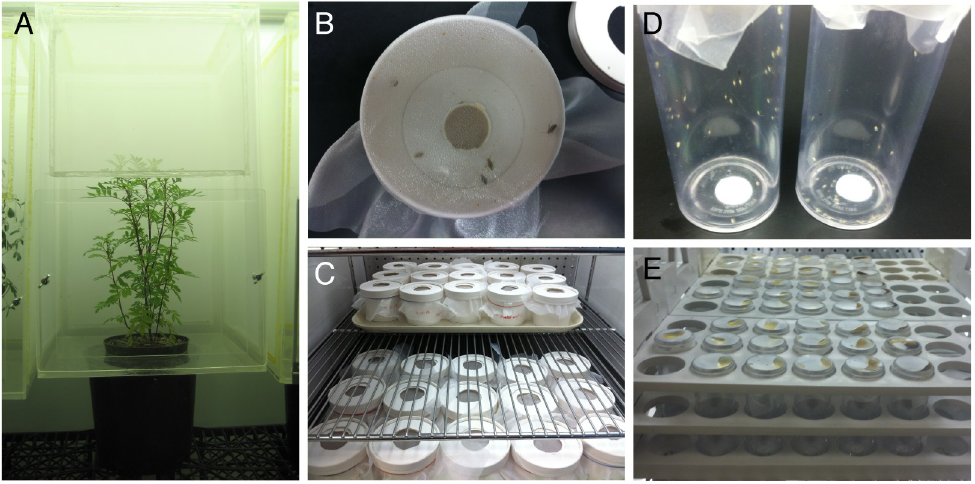
Fig 1. On-plant and diet-incorporation assays for adult Lygus hesperus and Bemisia tabaci . For on-plant assays (A), live adults were released into plexiglass cages with either marigold or control (common bean) plant and survival was assessed daily for 13 d. For incorporation assays, marigold extracts were mixed into diets for L . hesperus (B and C) or B . tabaci (D and E) and survival was recorded daily for up to 3 ( B . tabaci ) or 14 d ( L . hesperus ).